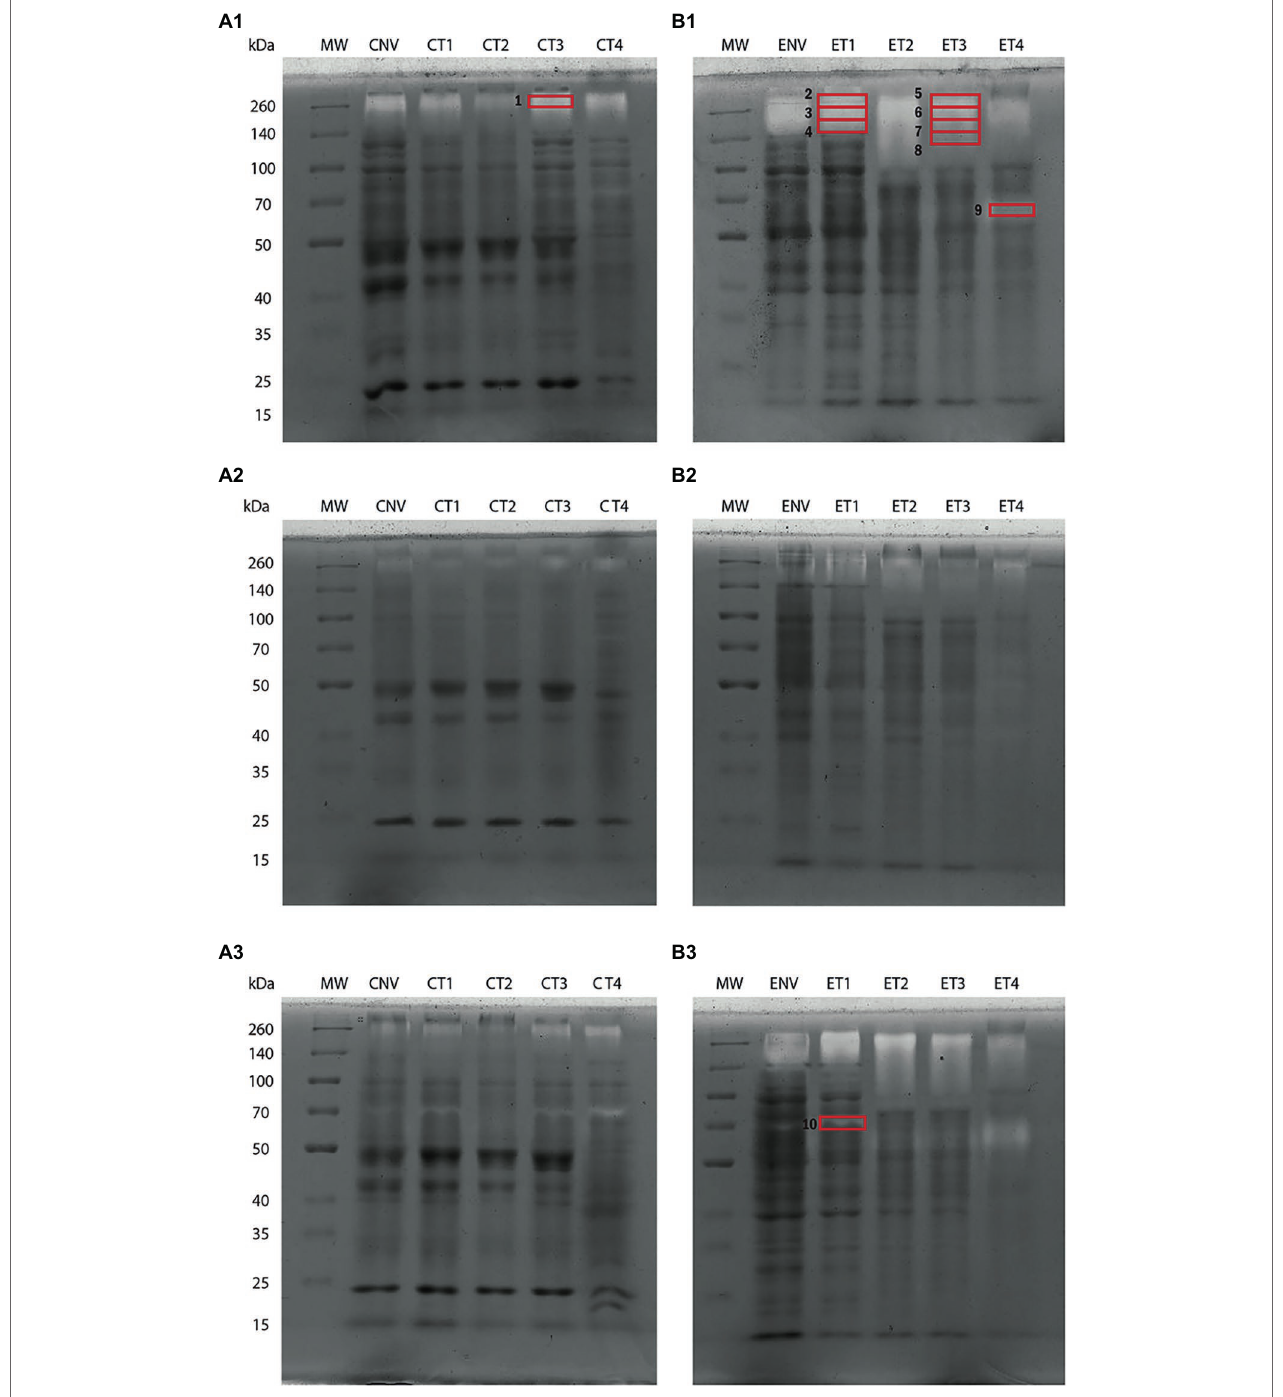
FIGURE 4 | Protease activity in 9% polyacrylamide gel slabs containing gelatin at different germination stages. Cotyledon samples (A) . Embryo axis samples (B) : Gels containing no inhibitor (1); an inhibitor of serine protease activity (PMSF; 2); and one of metalloprotease activity (EDTA; 3). NV: Nongerminated acorns after 4 weeks of germination. T1: mature acorns prior to germination. T2, T3, T4: Germinated acorns when root tips were visibly emerging from cotyledons (T2), their size reached 6.5 mm (T3) and it exceeded 20 mm (T4). Ten bands were cut from protease activity gels for shotgun analysis (red